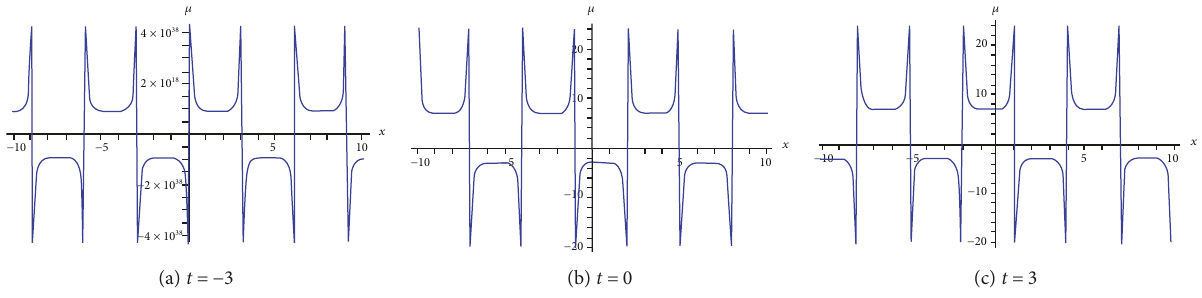
Figure 3: Nonlinear dynamical evolutions of solution (24) determined by